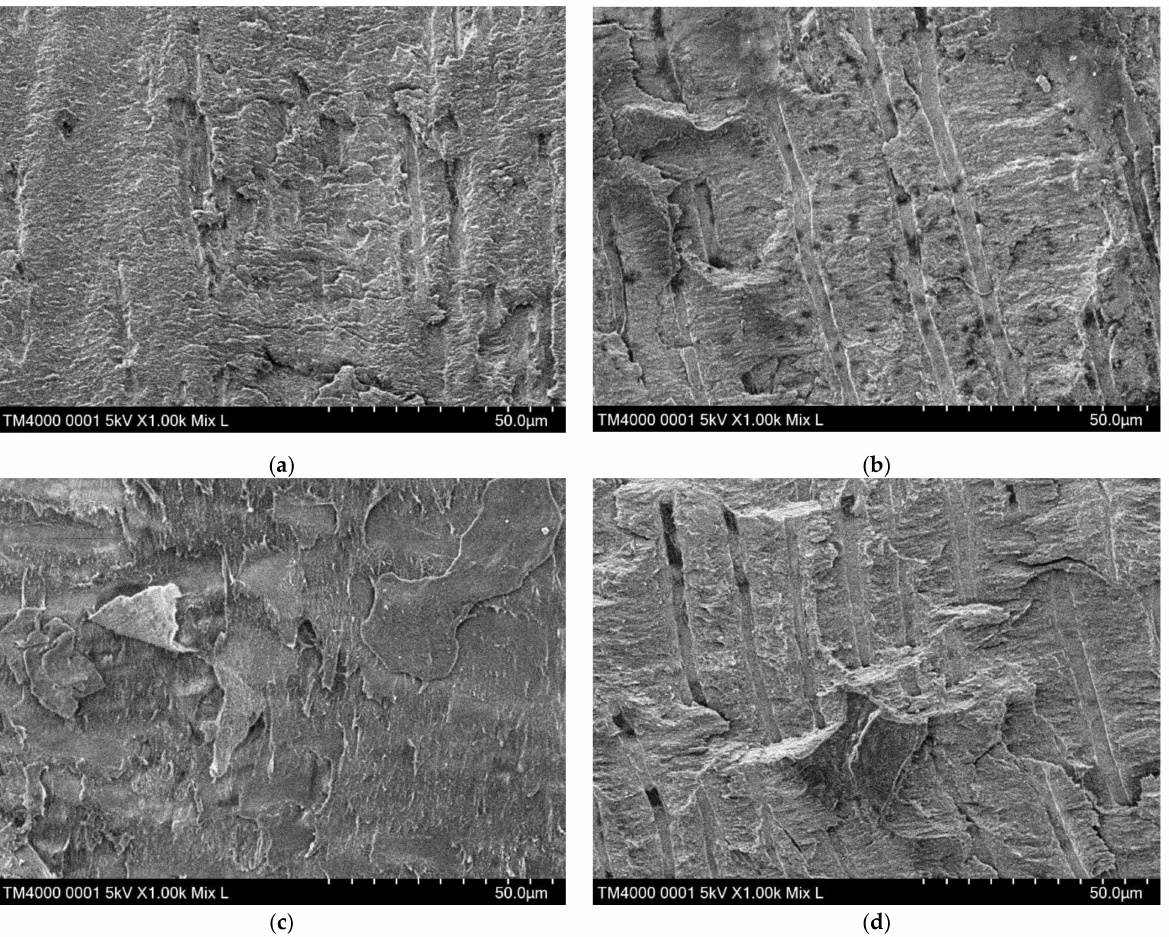
Figure 4. Representative SEMs of typical failure modes in each of the EC groups. ( a ) EC group: the dentin surface is covered with a smear layer and a few unclear dentinal tubules; ( b ) EC-G group: the dentinal tubules are clearly observed; ( c ) EC-P group: the structure of the dentin surface is amorphous; ( d ) EC-E group: the dentinal tubules are clearly observed. SEM, scanning electron microscope; EC,